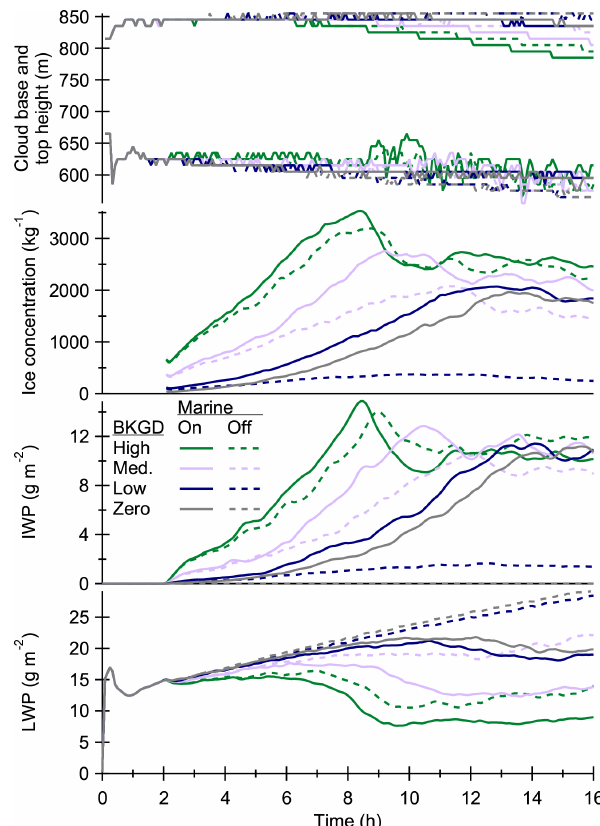
Figure 2. Time series of cloud base and top heights, ice crystal number concentration, and ice (IWP) and liquid (LWP) water paths (from top to bottom) from the eight model simulations with dif- ferent background (BKGD) aerosol INP concentrations (zero, low, medium, and high) and marine INP emissions switched on (solid lines) or off (dashed